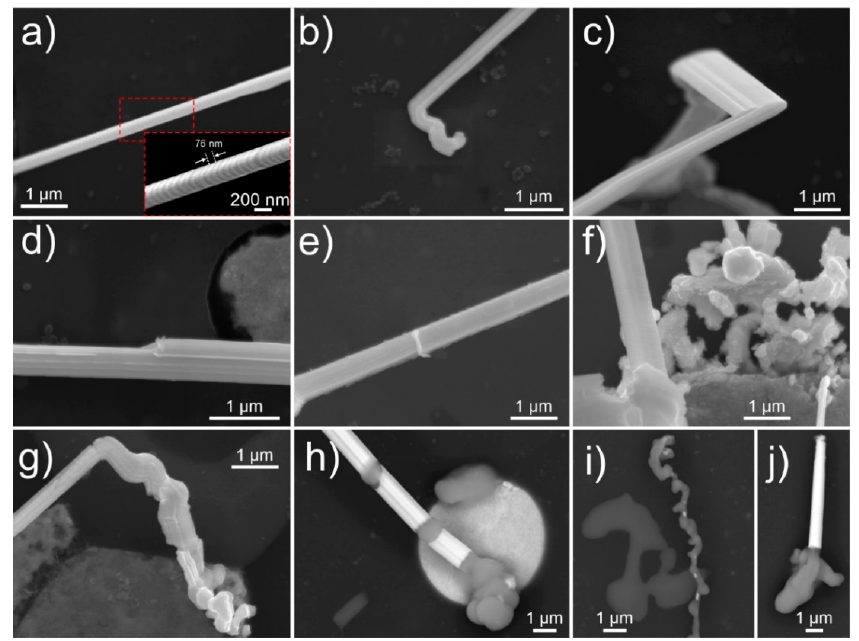
Figure 5. ( a – j ) Scanning electron microscopy micrographs of Pb whisker segments indicating the various observed growth phenomena. Images ( a – g ) are obtained with secondary electron imaging, image ( h – j ) are obtained with backscattering electron imaging. The insert in figure ( a ) displays the enlarged areas marked by dashed red